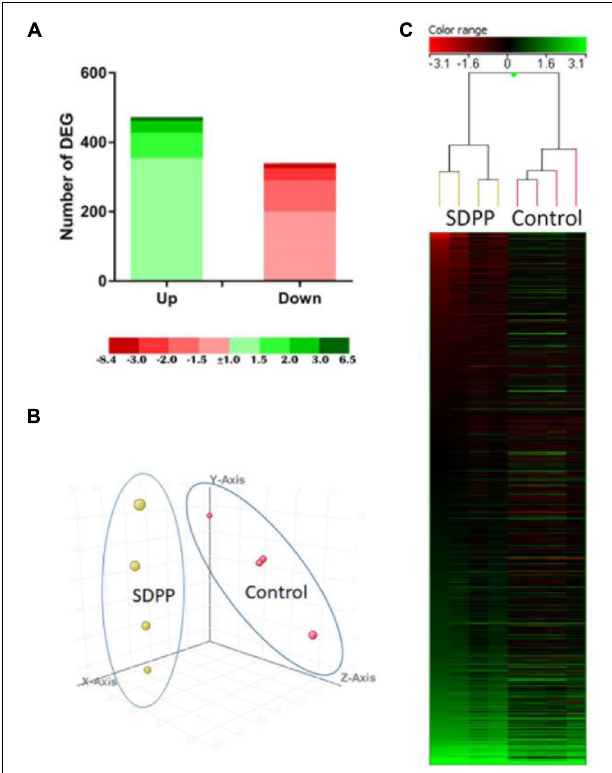
FIGURE 1 | Anterior intestine microarrays-based transcriptomic analysis for gilthead sea bream fed the SDPP diet. (A) Number of total differential expressed genes (DEGs). The green (upregulation) and red (downregulation) color scheme indicate the gene modulation according to its magnitude interval (fold-change). (B) Principal component analysis (PCA). Control (red spheres) and SDPP groups (yellow spheres) are represented. Each array included in the study is represented by one sphere. (C) Hierarchical clustering heatmap representing the 803 DEGs. The results of each microarray analyzed for the control and SDPP group are shown. The green (up-regulation) and red (down-regulation) color scheme indicates the gene modulation according to its magnitude interval